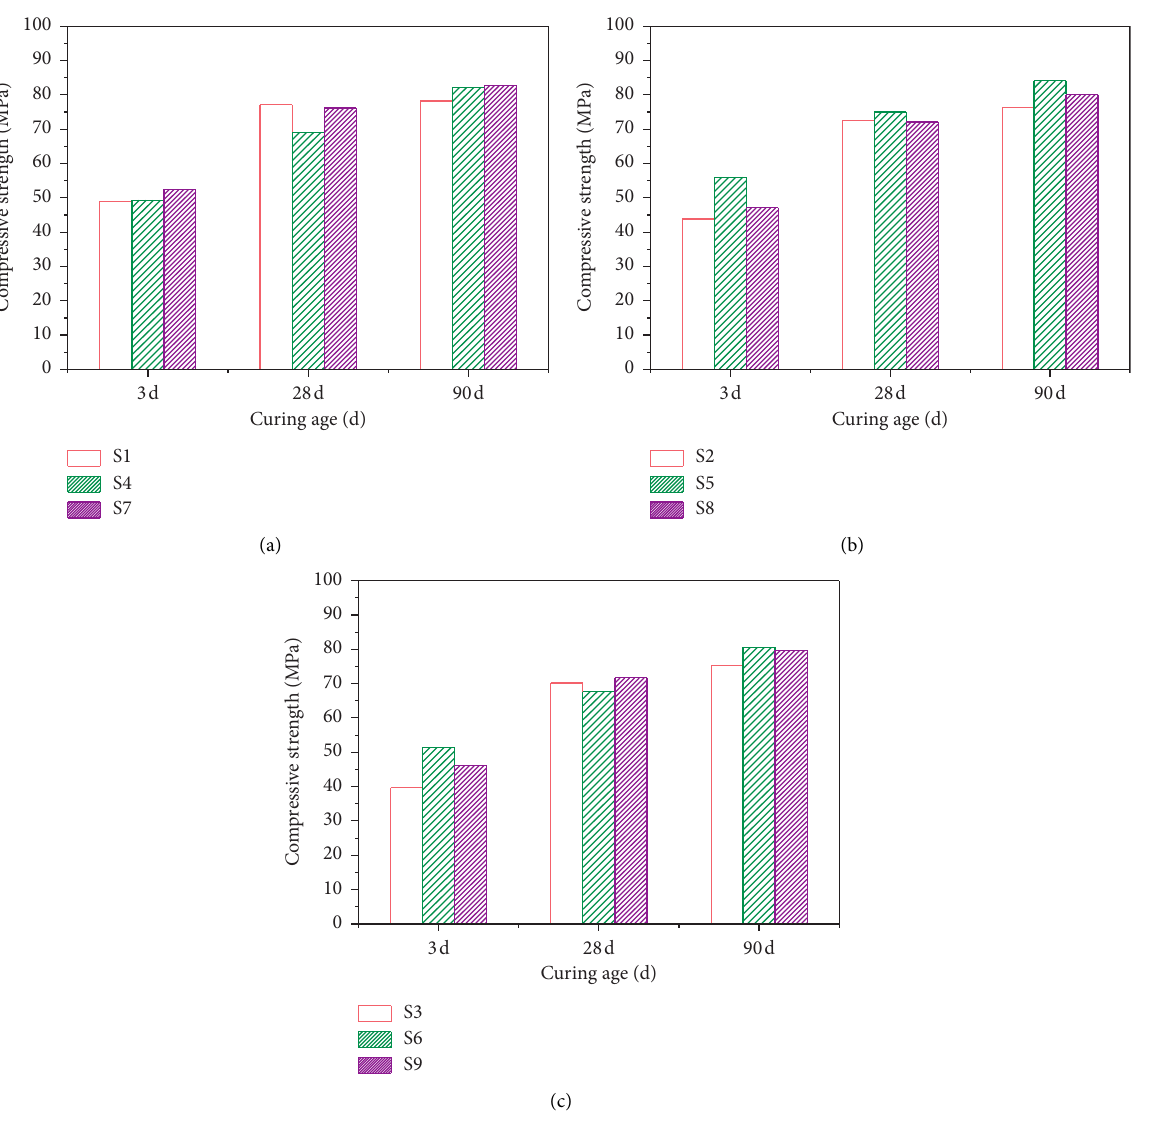
Figure 4: Compressive strength of HPC with different amounts of mineral admixtures. (a) 10%; (b) 20%; (c) 30%.